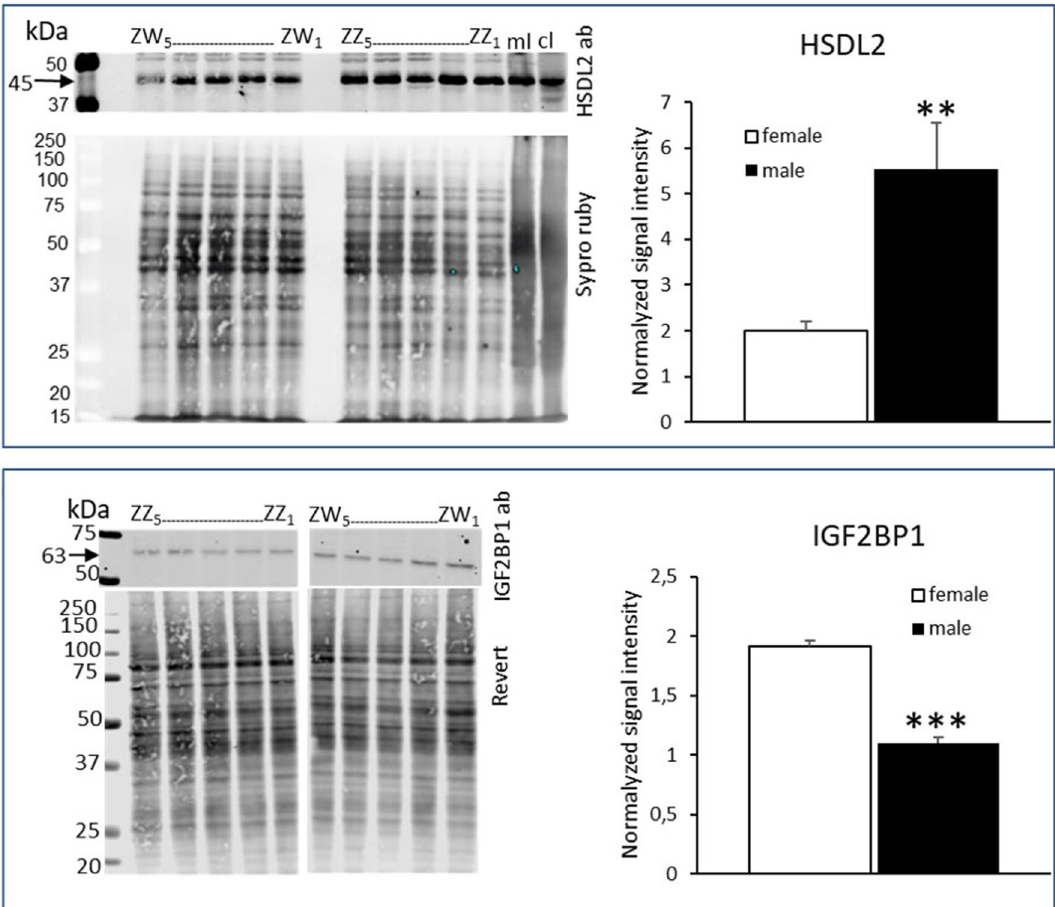
Figure 1. Western blot analysis of HSDL2 (at the top) and IGF2BP1(at the bottom) in chicken male and female PGCs derived in vitro. Western blot analysis was performed on the protein extracts from 5 individual female (ZW 1–5 ) and male (ZZ 1–5 ) PGCs cultures as described in the Sect. Reverse transcription quantitative real time polymerase chain reaction (RT-QPCR). The pictures of nitrocellulose membrane with blotted proteins after total protein staining and after incubation with HSDL2 and IGF2BP1 are represented. For IGF2BP1 two presented parts of the blot correspond to the same blot. The full-length blots for HSDL2 and IGF2BP1 are presented on the Supplementary Fig. S2. The bands of 45 kDa and of 63 kDa corresponding to HSDL2 and IGF2BP1 proteins respectively are indicated with arrows. Mouse liver (ml); chicken liver (cl) present positive controls. The results on the graphs represent the means ± SEM, p < 0.001 (***), p < 0.02